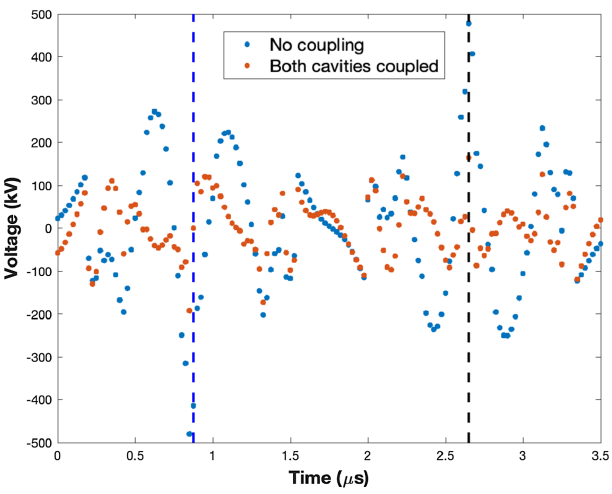
FIG. 13. Coupled cavity feedback block diagram. Solid lines show feedback inputs from cavities the LLRF system controls. Dashed lines show feedback inputs from other cavities.